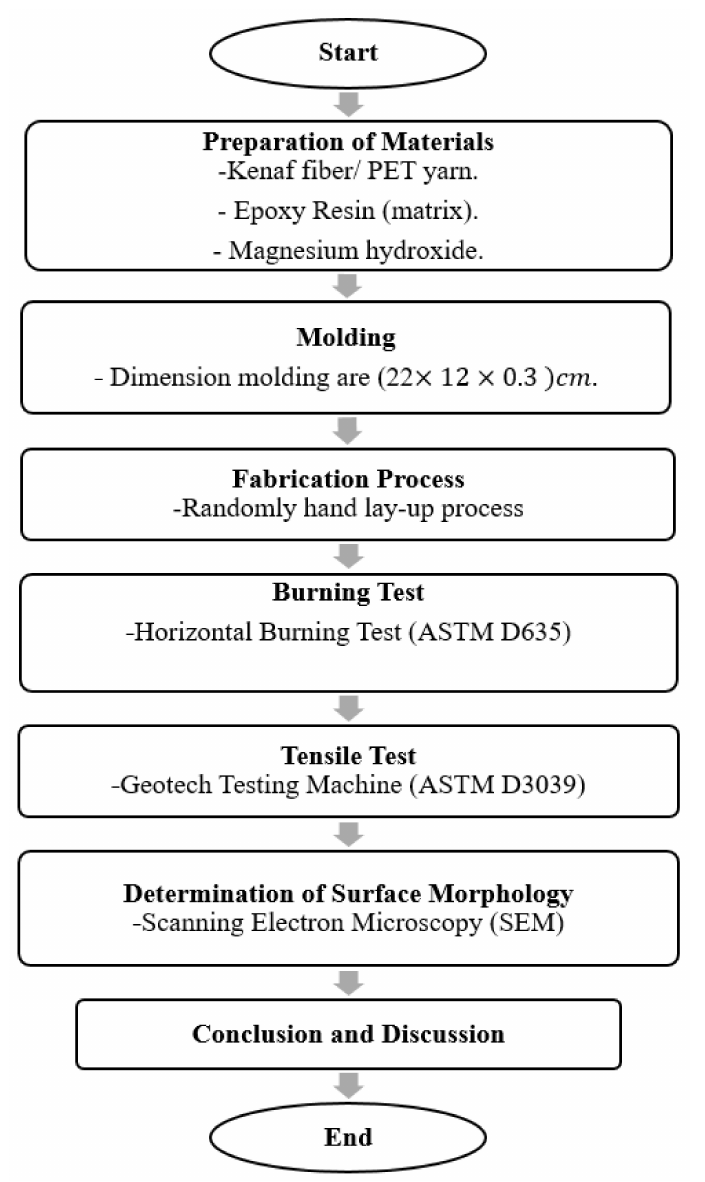
Figure 1. Research